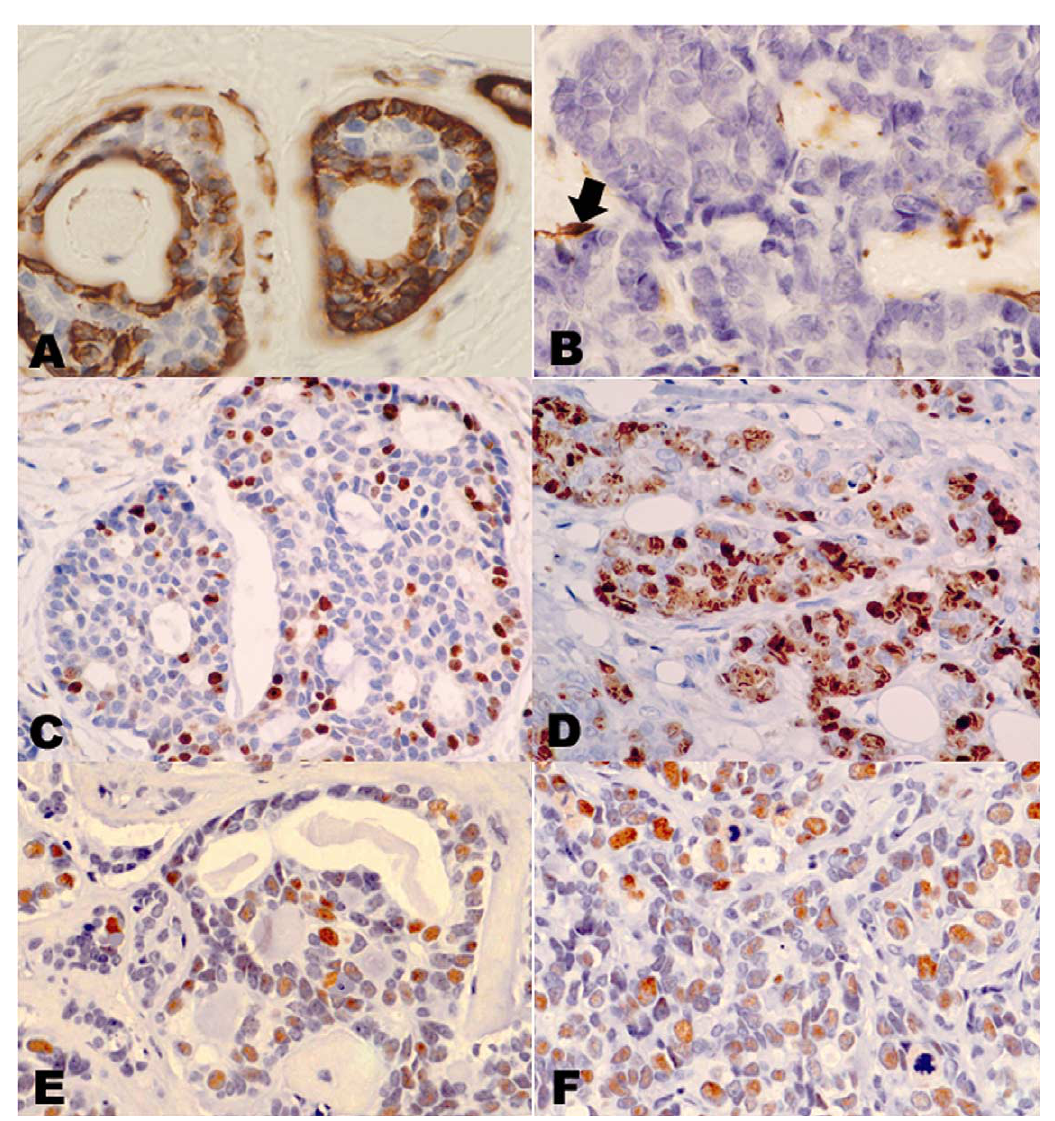
Fig. 2. Expression of α -SMA in myoepithelial cells of conventional area (A) and transformed area (B) of ACC-HGT (case F). The transformed component shows few positive myoepithelial cells (arrows) for α -SMA, demonstrating the loss of biphasic ductal-myoepithelial differentiation in this area. Ki-67 (case C) and p53 (case A) expression in conventional areas (C, E) and in transformed component (D, F). Original magnification 400 × (A, B, C and D). (Colors are visible in the online version of the article;